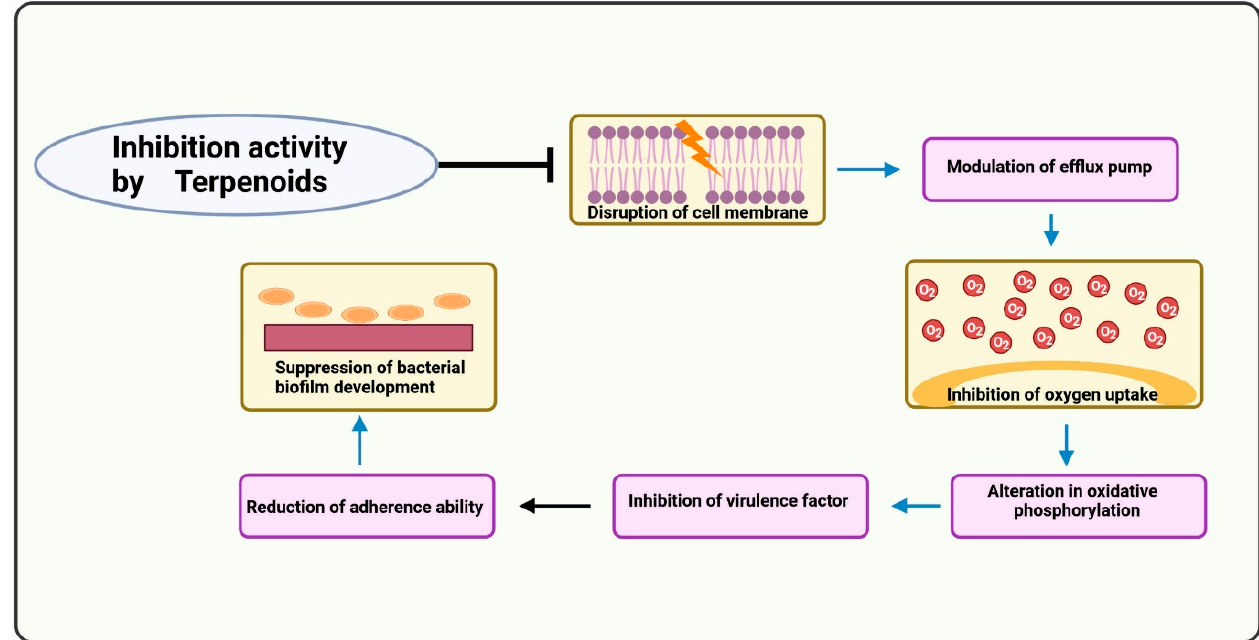
Figure 5. Mechanism of action of terpenoids. Terpenoids disrupt the cell membrane. The efflux pump is modulated, which might reverse antimicrobial resistance. The oxygen uptake process is blocked, resulting in the inhibition of oxygen. The oxidative phosphorylation process is altered, inhibiting other virulence factors. The fatty acid synthase enzyme and peptidoglycan production are blocked, suppressing biofilm production.